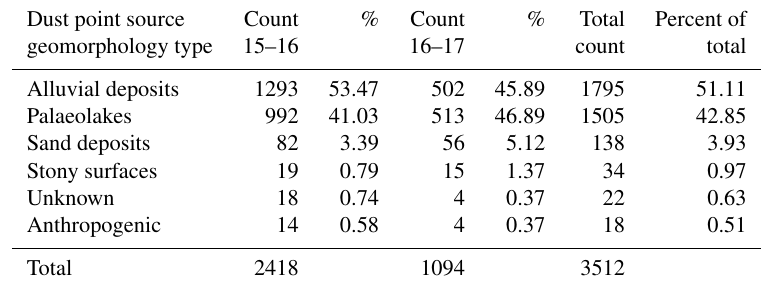
Table 1. Northern African mineral dust point sources of the 2015–2017 winter dust seasons classified by geomorphology type.